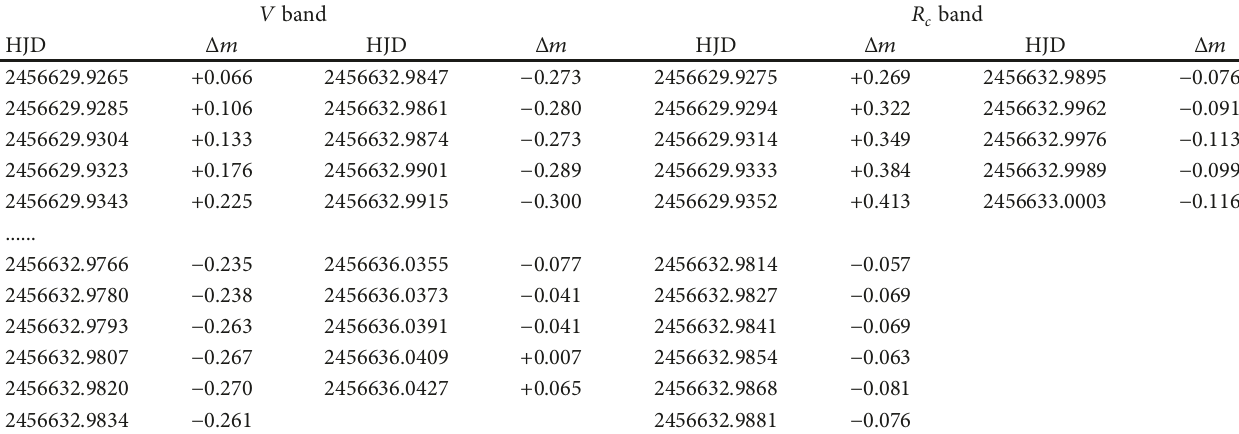
Table 1: CCD photometric observations in 𝑉 and 𝑅 𝑐 bands.